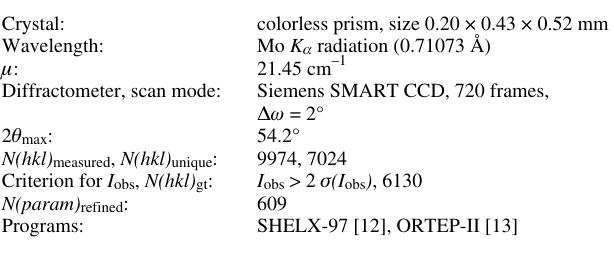
Table 1. Data collection and